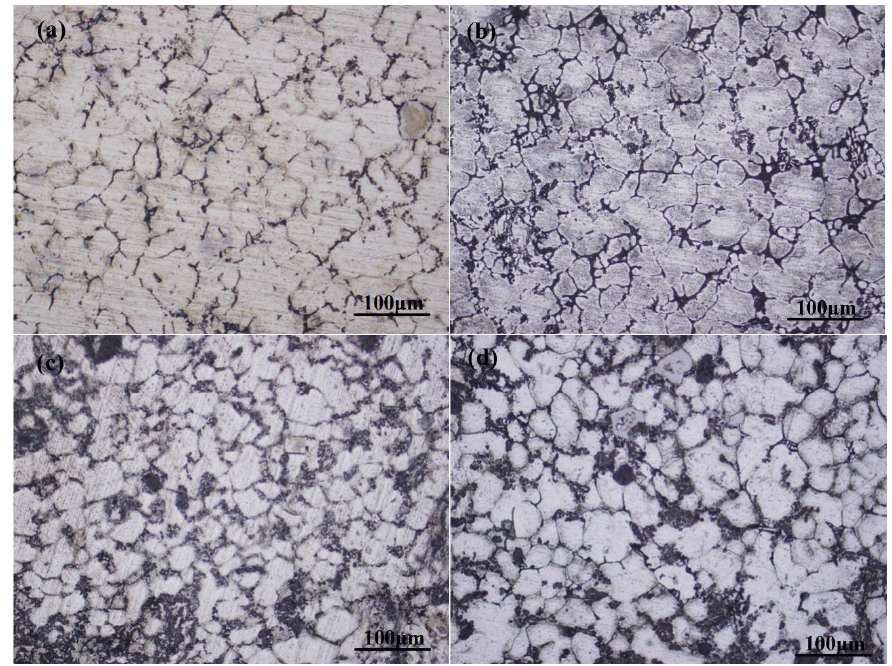
Figure 11. Influence of volume fraction of nano-sized Al 2 O 3 on mechanical properties of rheoformed 2024 aluminum matrix composite component reinforced by 5 vol % Al 2 O 3 nanoparticles at 620 °C for 25 min stirring